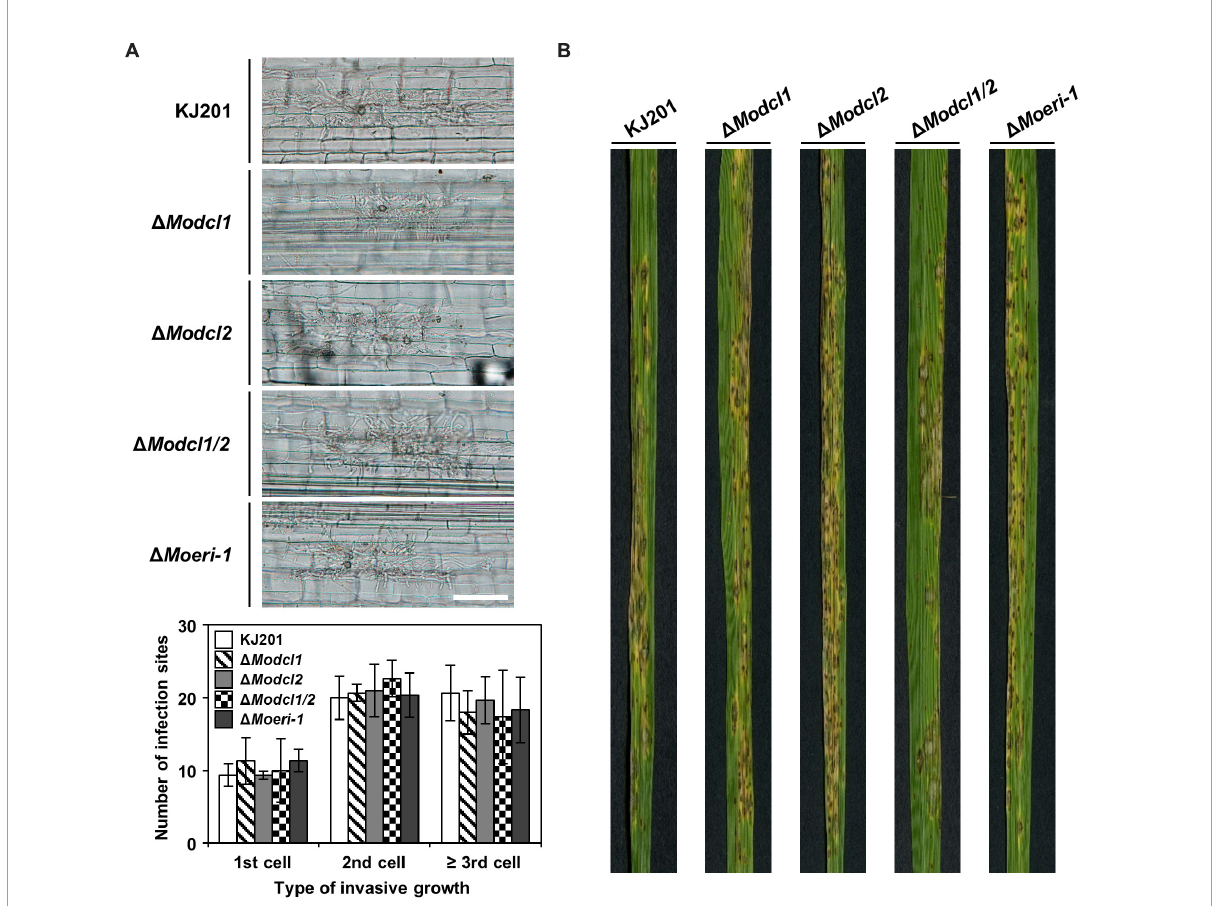
FIGURE6 Pathogenicity of Magnaporthe oryzae WT and deletion mutants. (A) Conidial suspensions (2 × 10 4 /mL) were inoculated onto rice sheath cells of 6-week-old Nakdong. Invasive growth of the WT and deletion mutants in sheath cells at 48 h post-inoculation was observed under light microscopy. The types of invasive growth were rated as 1st cell, 2nd cell, or ≥ 3rd cell colonization. Fifty infection sites of each sample were counted in triplicate. Error bars indicate the standard deviations of mean values. Student’s t -test between the mean values of the WT and the mutant strains indicated that there are no significant differences. (B) 4-week-old cv. Nakdong rice seedlings were sprayed with conidial suspensions (5 × 10 4 /mL) of the WT and deletion mutant strains. Disease severity was measured at 7 days post-inoculation.